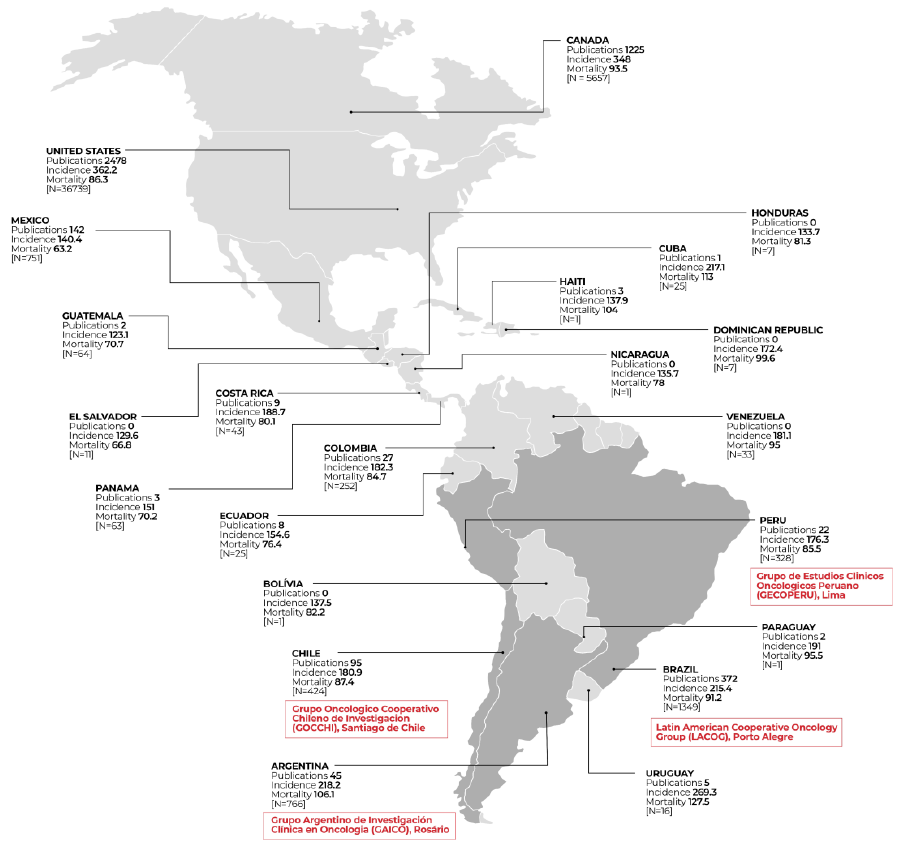
Figure 1. Headquarters of collaborative groups working in Latin America and the Caribbean, cancer incidence and mortality, and the number of cancer clinical trials (N) per country.